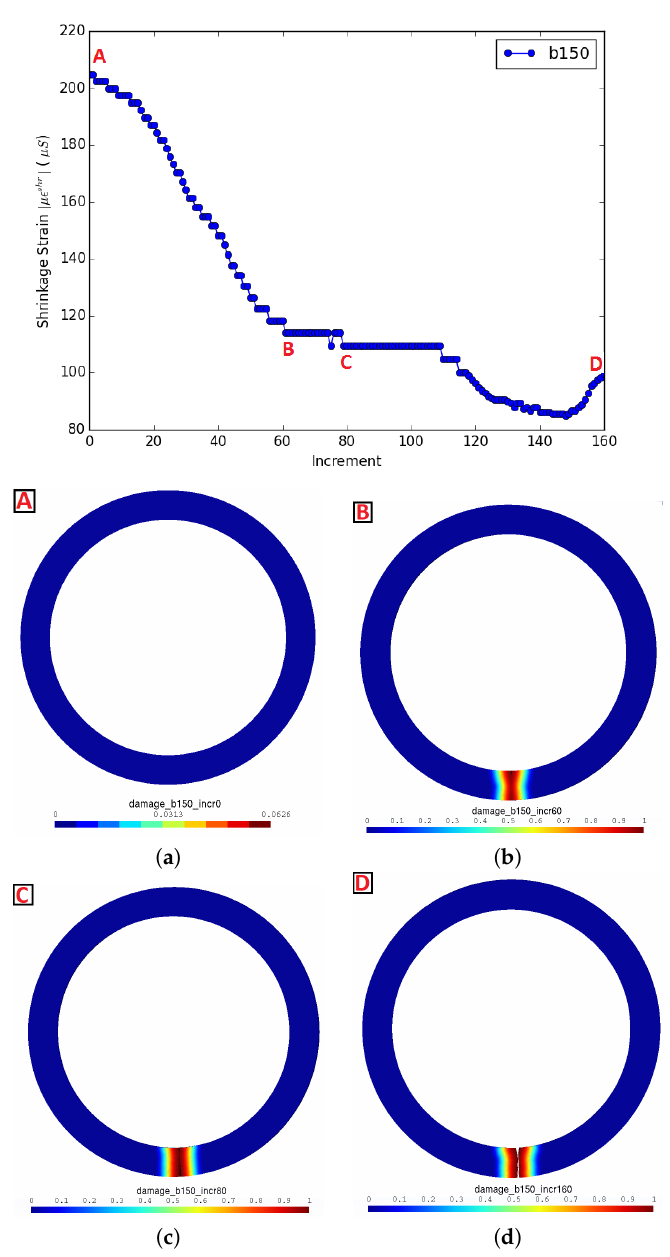
Figure 8. Critical shrinkage strain evolution as a function of increments and a top view of the damage field for four different moments of the simulation illustrated for a ( b ) crack initiation; ( c ) crack propagates on the top side; ( d ) crack breaks the